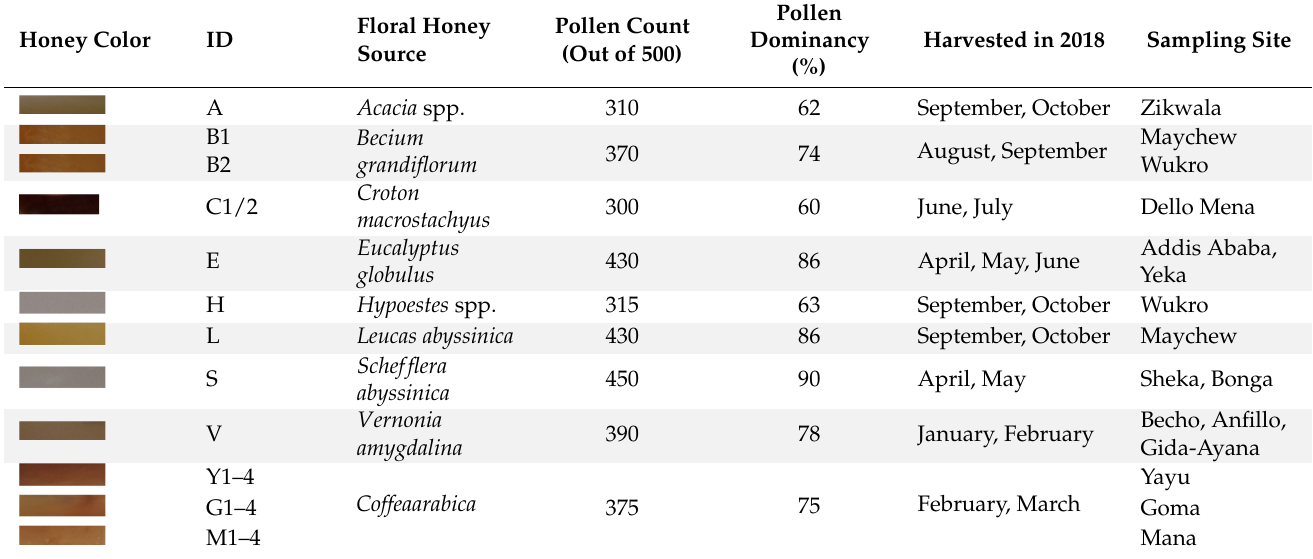
Table 1. Harvest period and Ethiopian sampling site of the collected floral honey samples with respective color depicted (ID numbers indicate individual samples